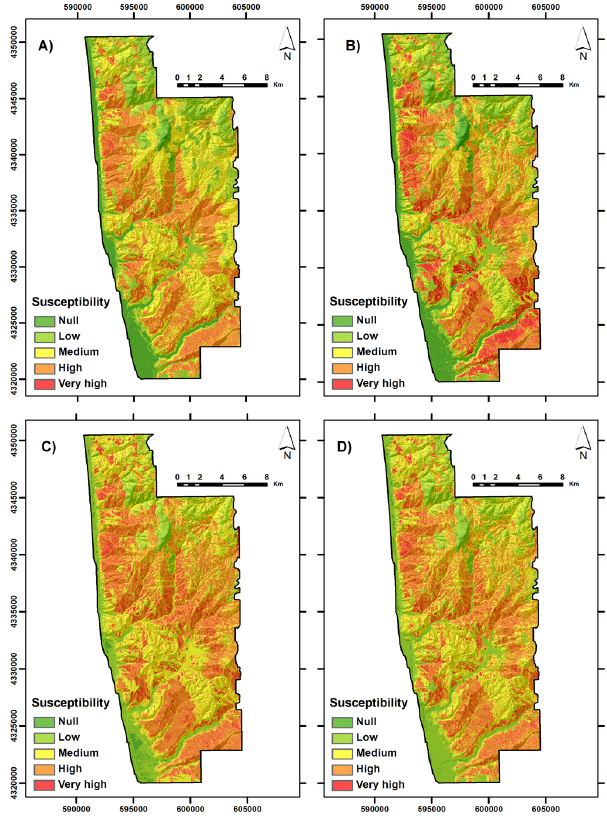
Fig. 4. Susceptibility maps obtained with square cells and grouped variables for tested sampling area: (A) All area; (B) Transects; (C) Buffer 1 / 1; (D) Buffer 1 /